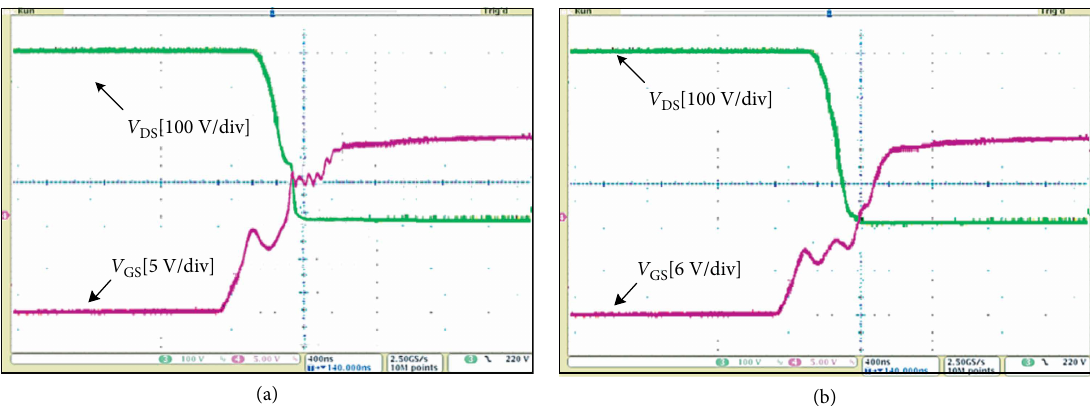
before and after dead-time 𝑇 d adjustment under light load. (a) 𝑇 d =1 μ s 3